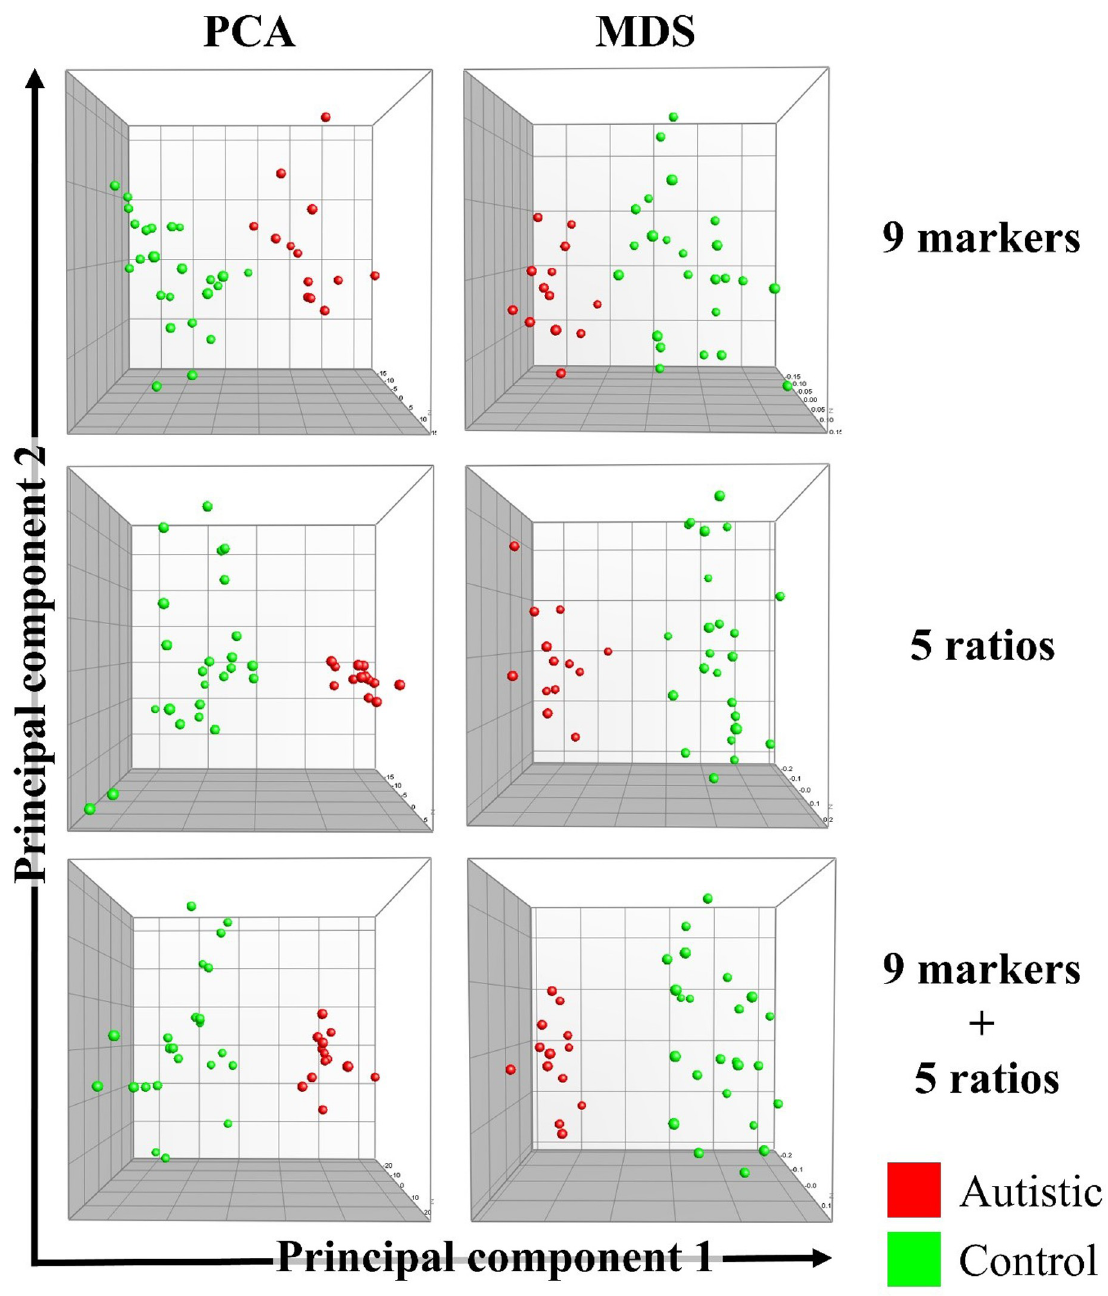
Fig 2. Complete separation of autistic individuals (n = 13) and age-matched healthy controls (n = 24) using principal component analysis (PCA) and multidimensional scaling (MDS). The 9 biomarkers used (top row) were potassium (K), sodium (Na), lactate dehydrogenase, glutathione (GSH), glutathione S-transferase (GST), creatine kinase (CK), co-enzyme Q10 (CoQ10), caspase 7 (Cas7), and melatonin (MLTN). The 5 ratios (middle row) were K:Na, GST:GLTN, CK:Cas7, CoQ10:Cas7, and Cas7:MLTN. A combined profile including the 9 biomarkers and the 5 ratios was also tested (bottom